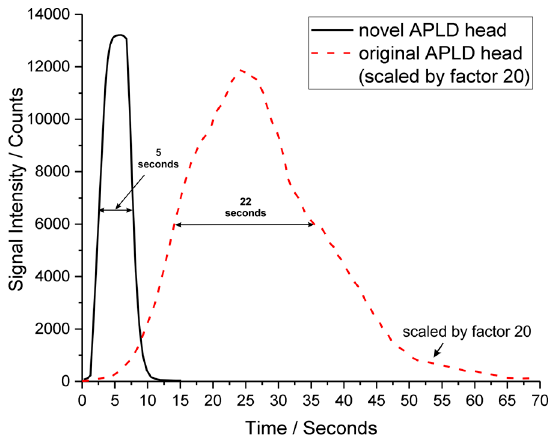
Figure 2. Compared smoothed desorption from spots with about 1.5 µg Tetryl. Measured at negative CI mode and fragment m / z 241. Novel system with short transferline and heated APLD head (solid line). Original measurement system with long transferline (dashed line). Compared is the full width at half maximum.